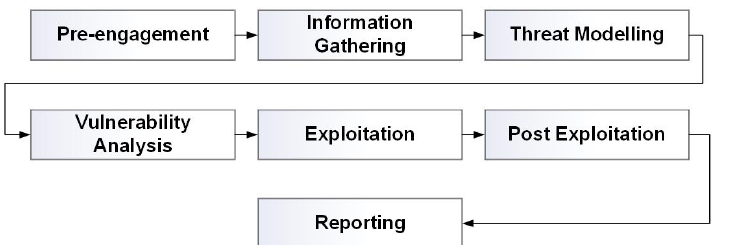
Figure 2. Flow Chart of the PTES framework Note: Adapted from “High Level Organization of the Standard” by Penetration Testing Execution Standard, n.d. (https://pentest-standard.readthedocs. io/en/latest/index.html) (accessed on 18 January 2022). Copyright 2016 by The PTES Team Revi- sion